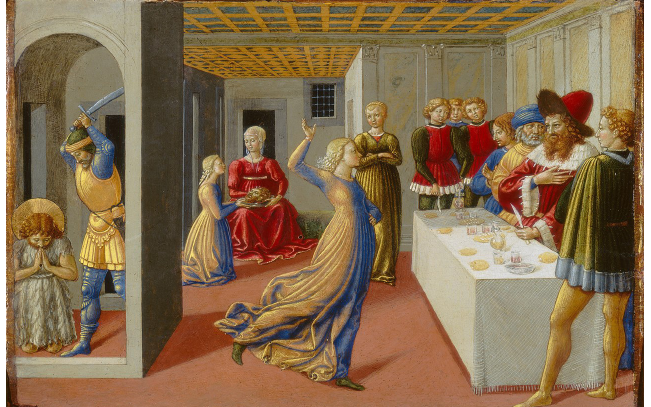
Fig. 4 Benozzo Gozzoli, Danza di Salome , 1461-1462 (Washington, National Gallery of